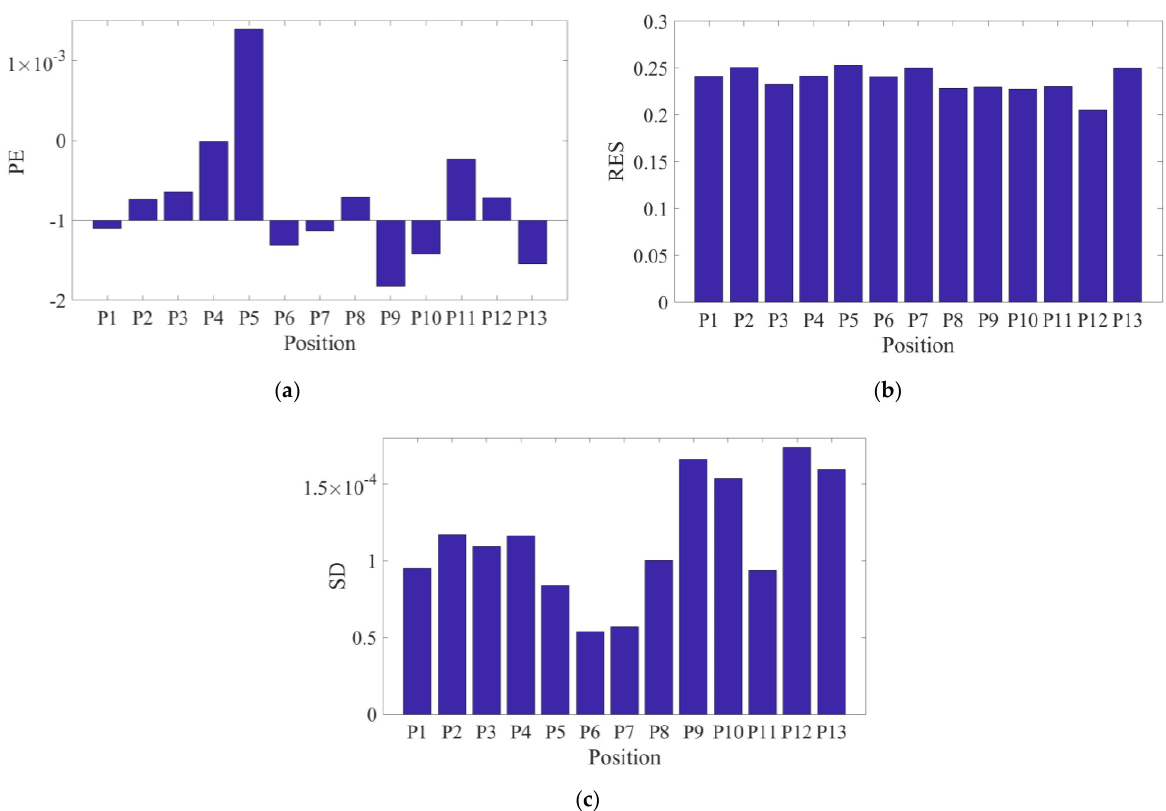
Figure 4. The results of ( a ) position error, ( b ) resolution, and ( c ) shape deformation of the reconstructed images are plotted with respect to each of the P1 to P13 test cases. Table 1. Electrical capacitance tomography imaging accuracy evaluation results. PE —position error; RES —resolution; SD —shape deformation.